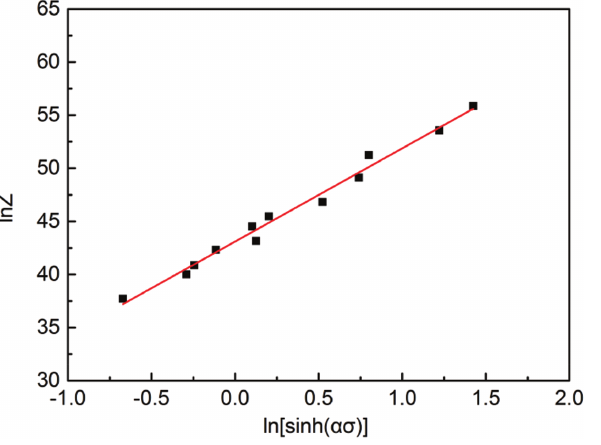
Figure 6: Relationship between ln Z and ln[sinh( ασ )].